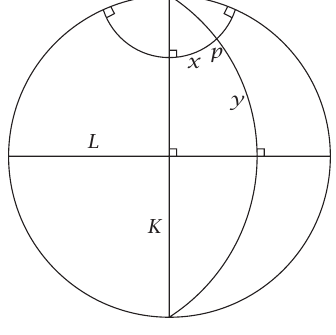
Figure 6.10 . Construction of a coordinate system on H 2